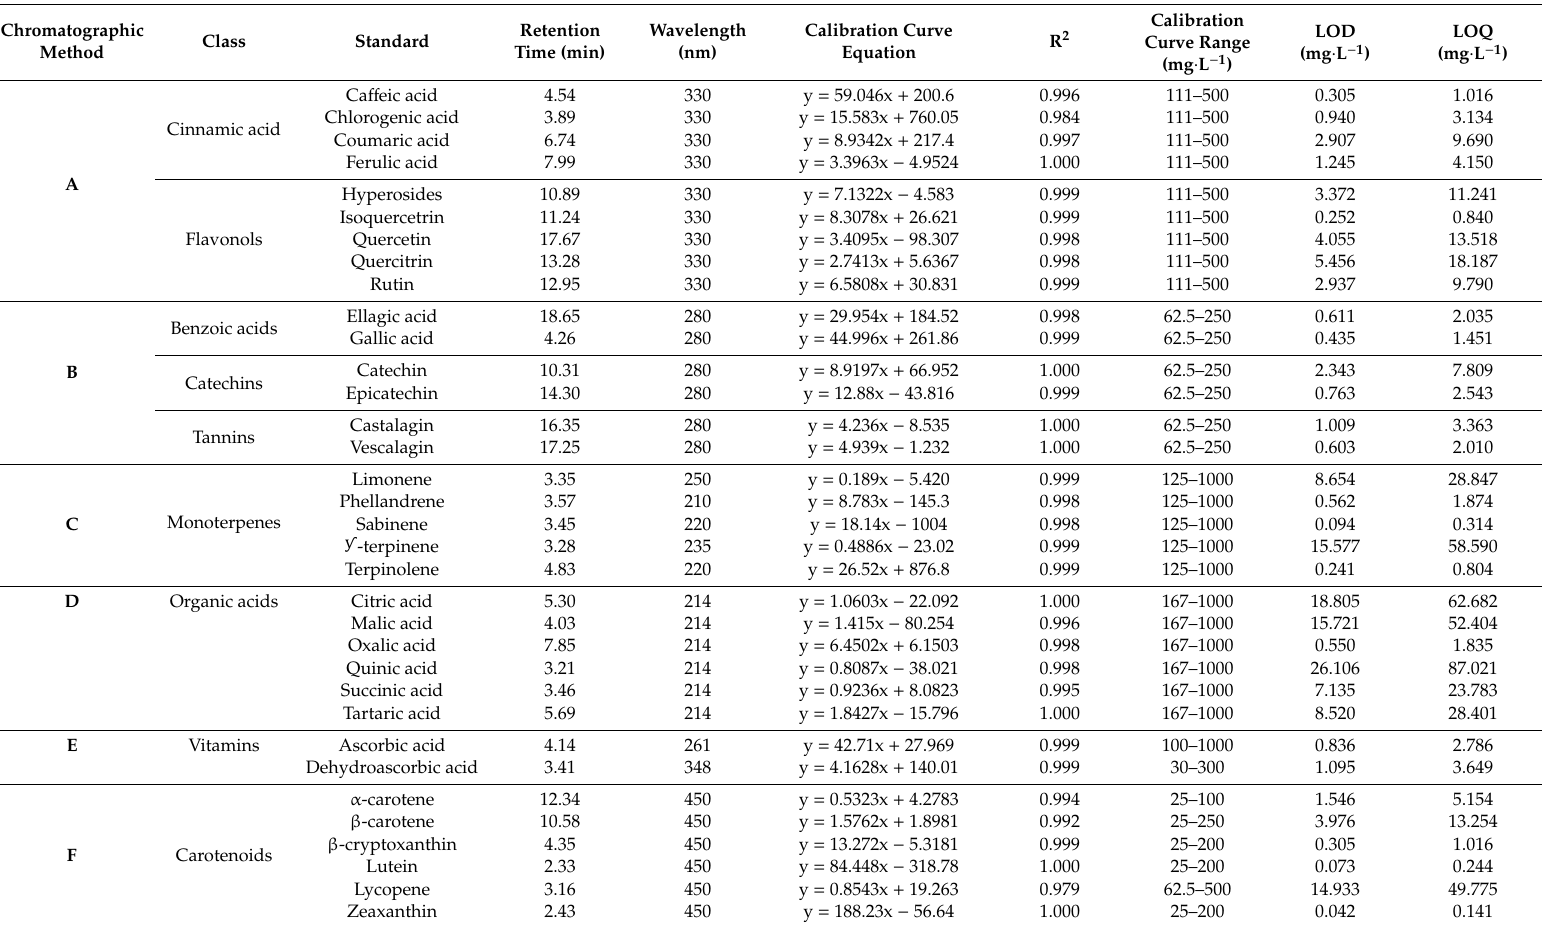
Table 6. Calibration curve, R 2 , LOD (limit of detection), and LOQ (limit of quantification) of each bioactive compound used as